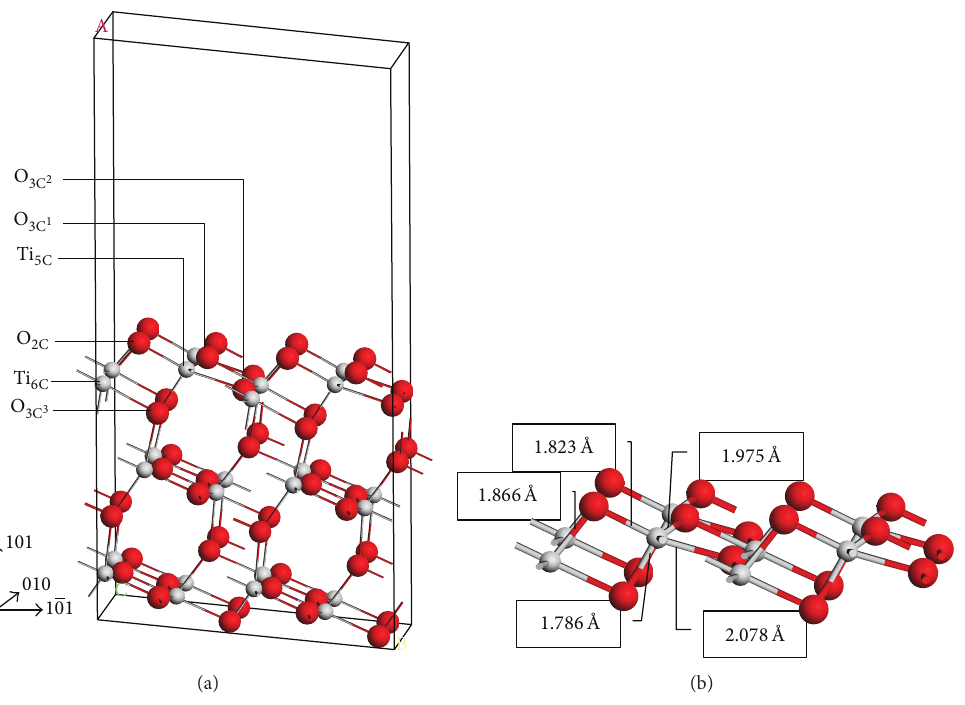
2 , the first layer is in the dashed line. (b) Relaxed with its neighboring O atoms and O 2 with its neighboring Ti atoms are labeled. Ti C C